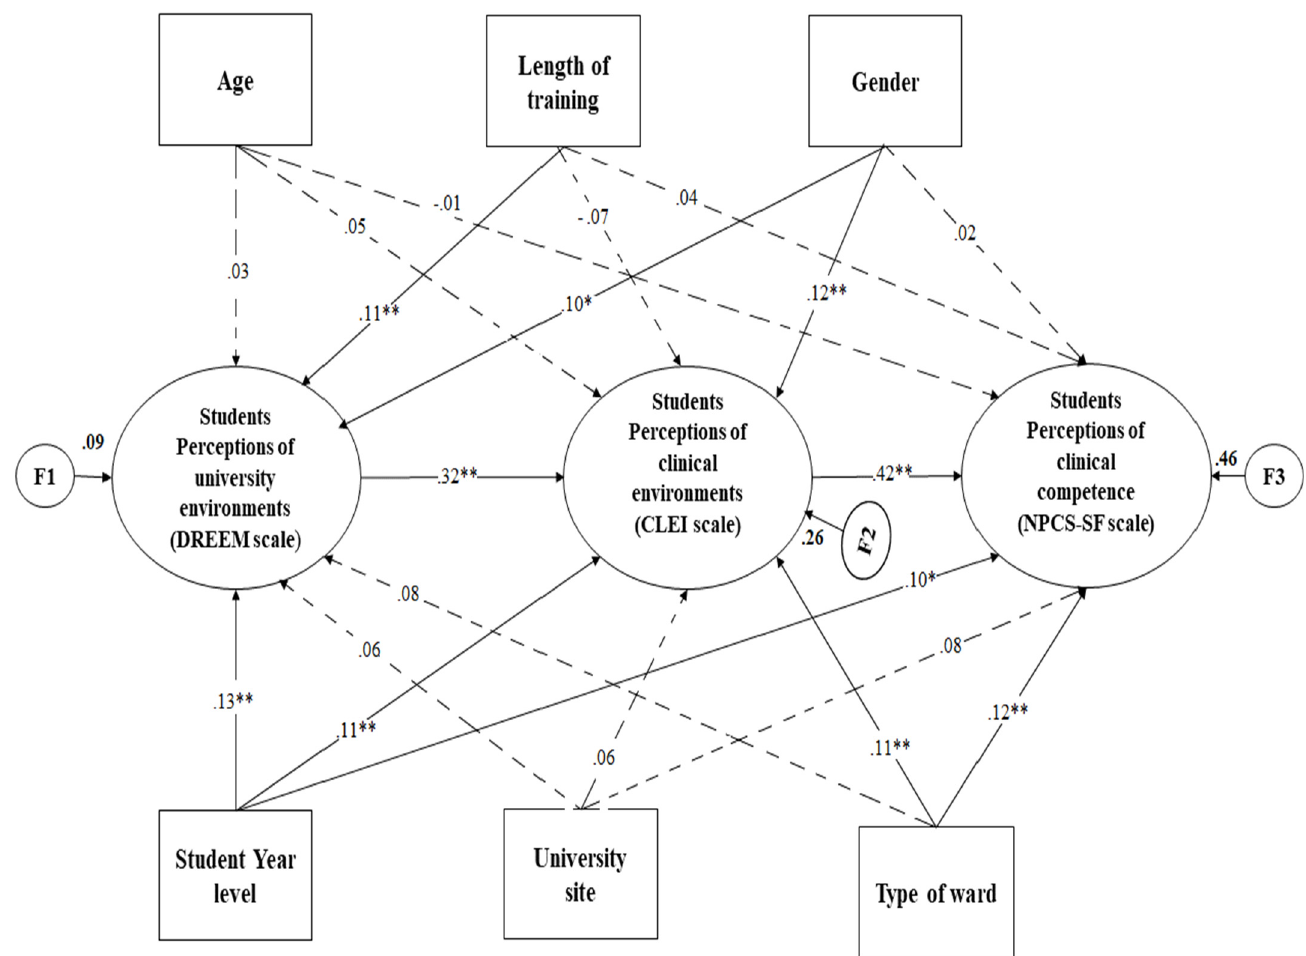
Figure 2. The tentatively hypothesized model predicting nursing students’ perceptions of professional competence, university environment, and clinical environment. Dotted lines show statistically insignificant paths. All estimates are standardized B coefficients. ** p < 0.001, * p < 0.05.